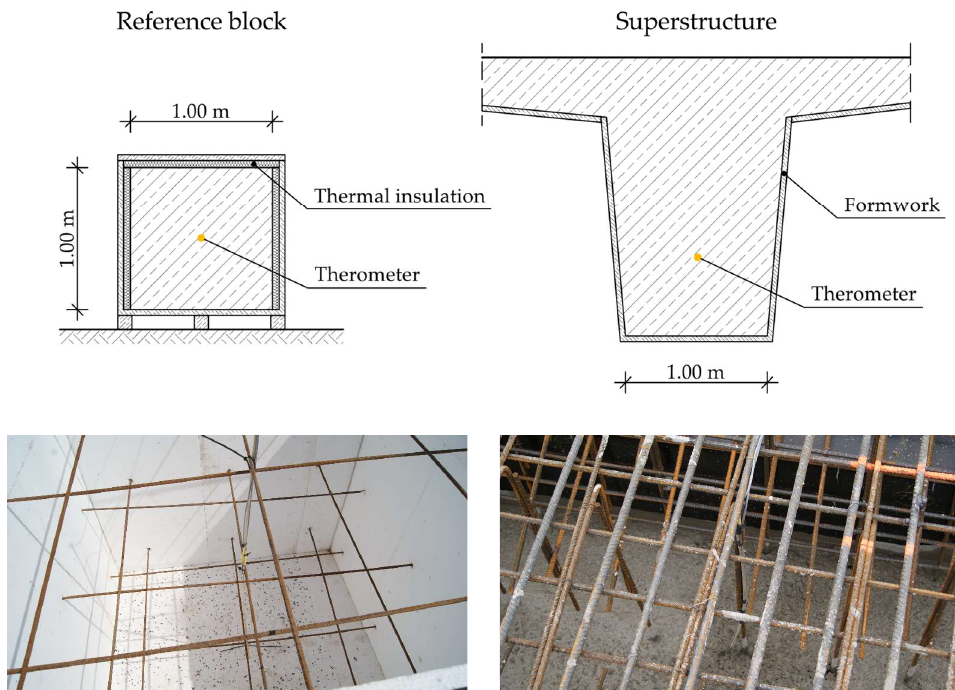
Figure 3. Arrangement of temperature sensors in the reference block and in the girder.